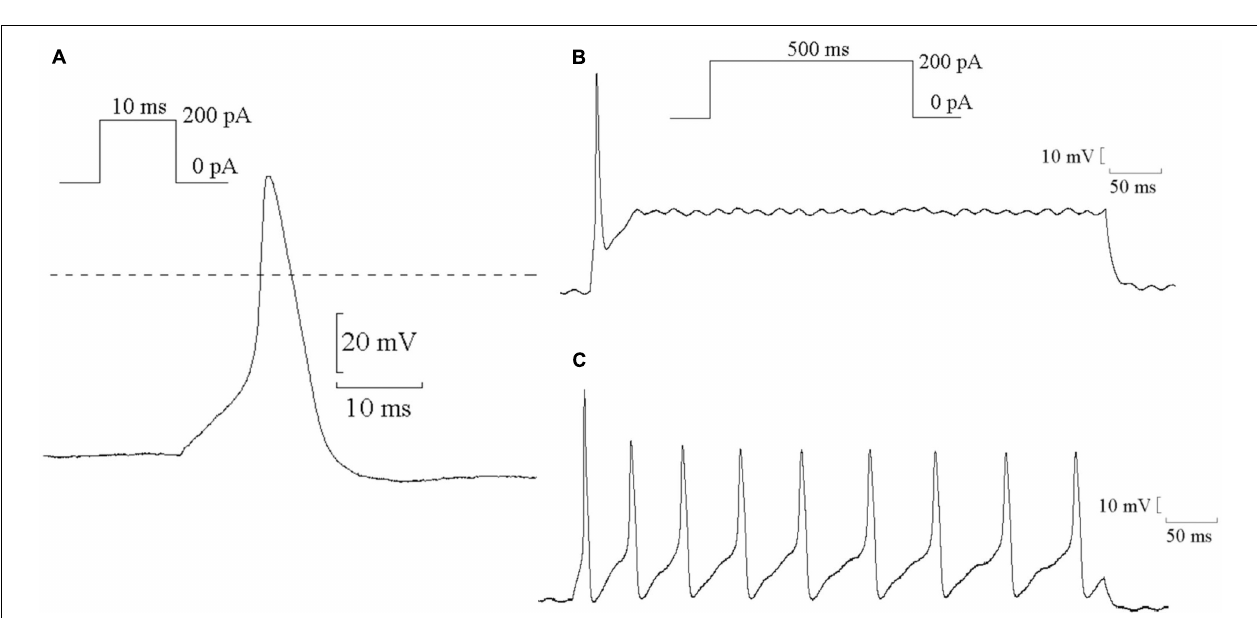
FIGURE 4 | Effects of MI and fluvastatin on intracellular calcium concentration in SCG neurons. (A) Representative recordings of calcium concentration. (B) The histogram showed the average peak value of intracellular calcium concentration (peak fluorescence level F/resting fluorescence level F0) in five groups. Each point represents mean ± SD.